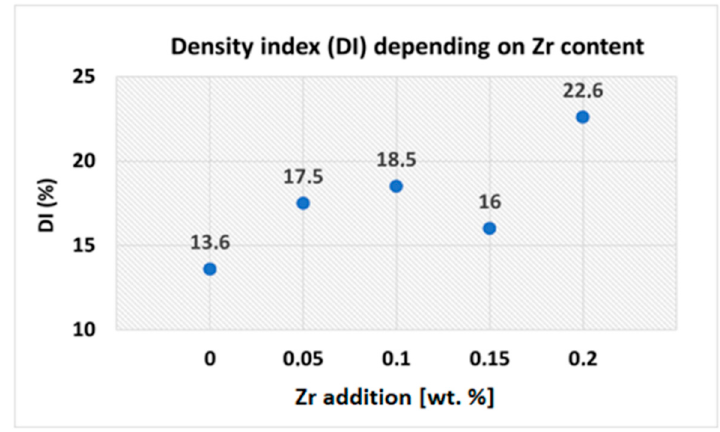
Figure 5. DI values of the experimental alloys .